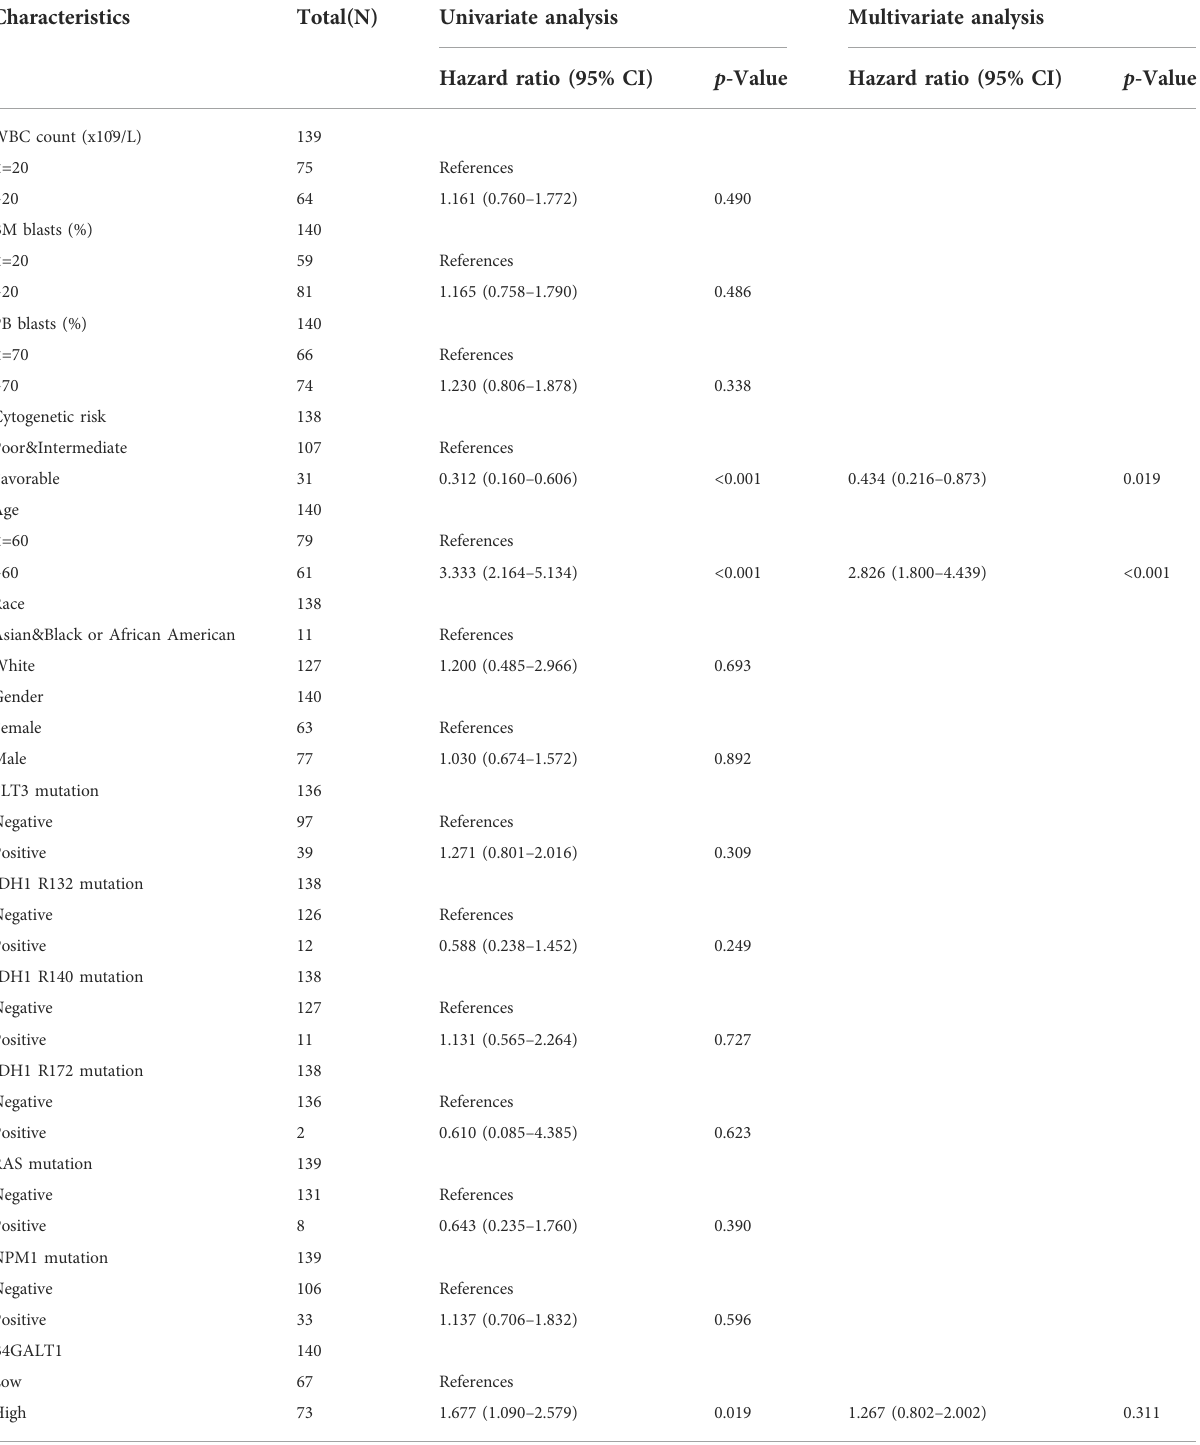
TABLE 3 Univariate and multivariate Cox ’ s regression analysis of factors associated with OS in